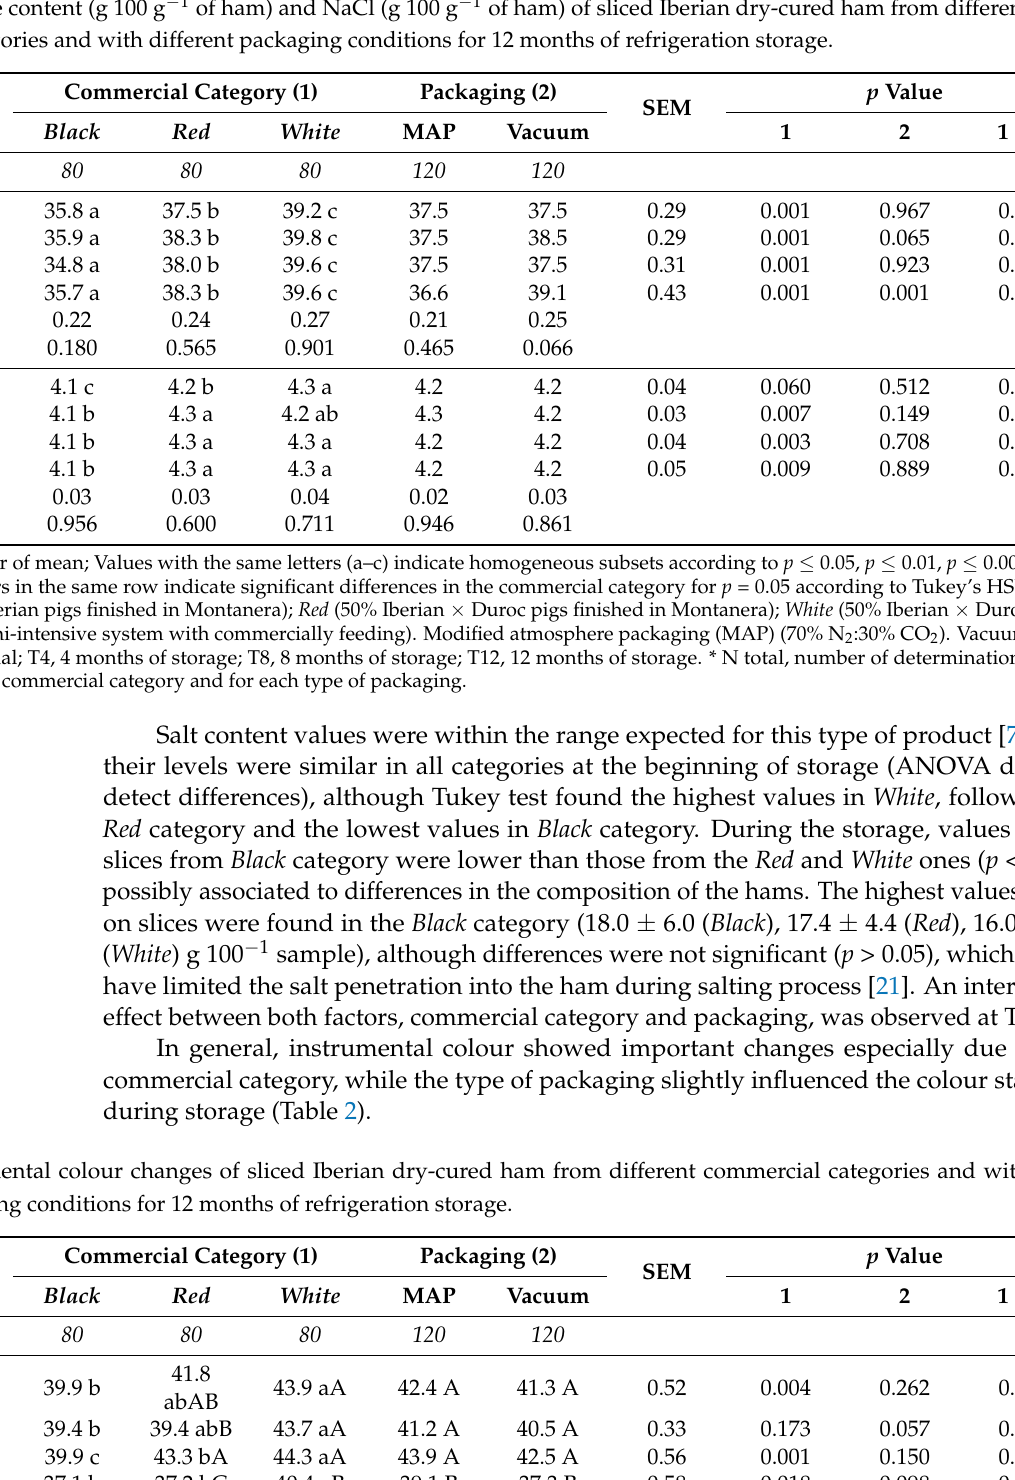
Table 1. Moisture content (g 100 g − 1 of ham) and NaCl (g 100 g − 1 of ham) of sliced Iberian dry-cured ham from different commercial categories and with different packaging conditions for 12 months of refrigeration storage.